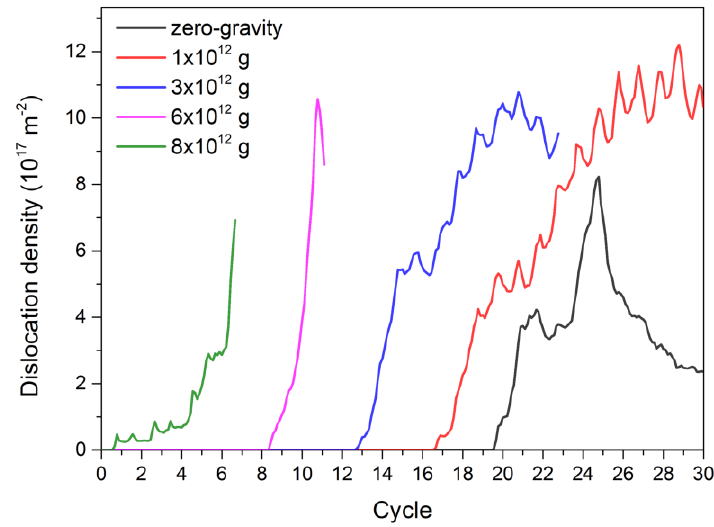
Figure 6. Dislocation density evolution under cyclic loadings.